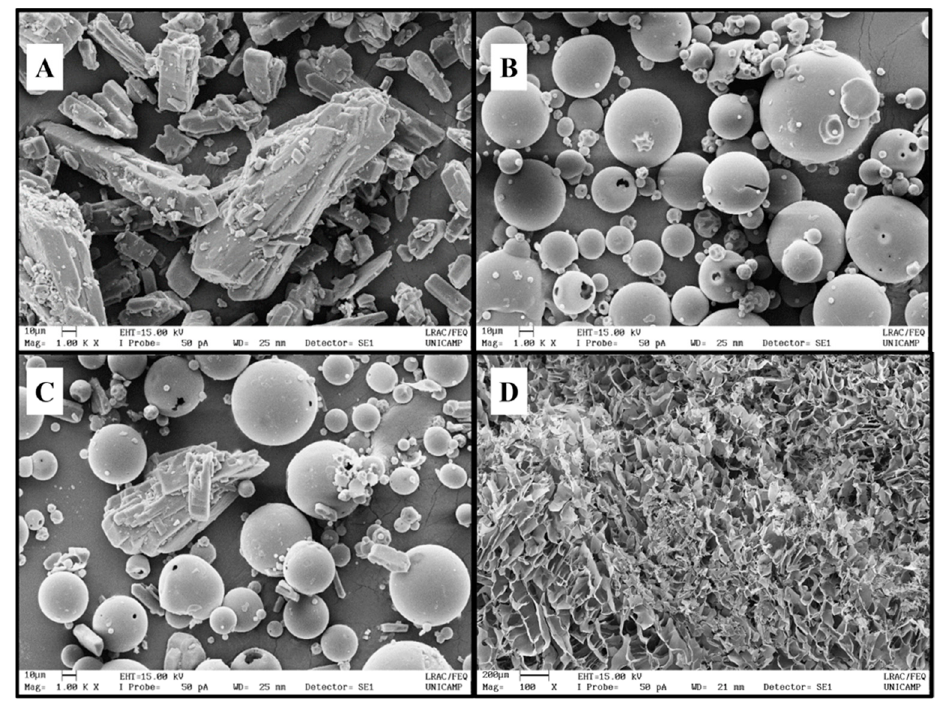
Figure 8. Scanning electron microscopy of ( A ) doxycycline hyclate (DX), ( B ) sulfobutylether- β -cyclodextrin (SBE- β -CD), ( C ) the physical mixture, and ( D ) the DX/SBE- β -CD complex. Table 2. Formulation parameters and visual analysis results of initial screening